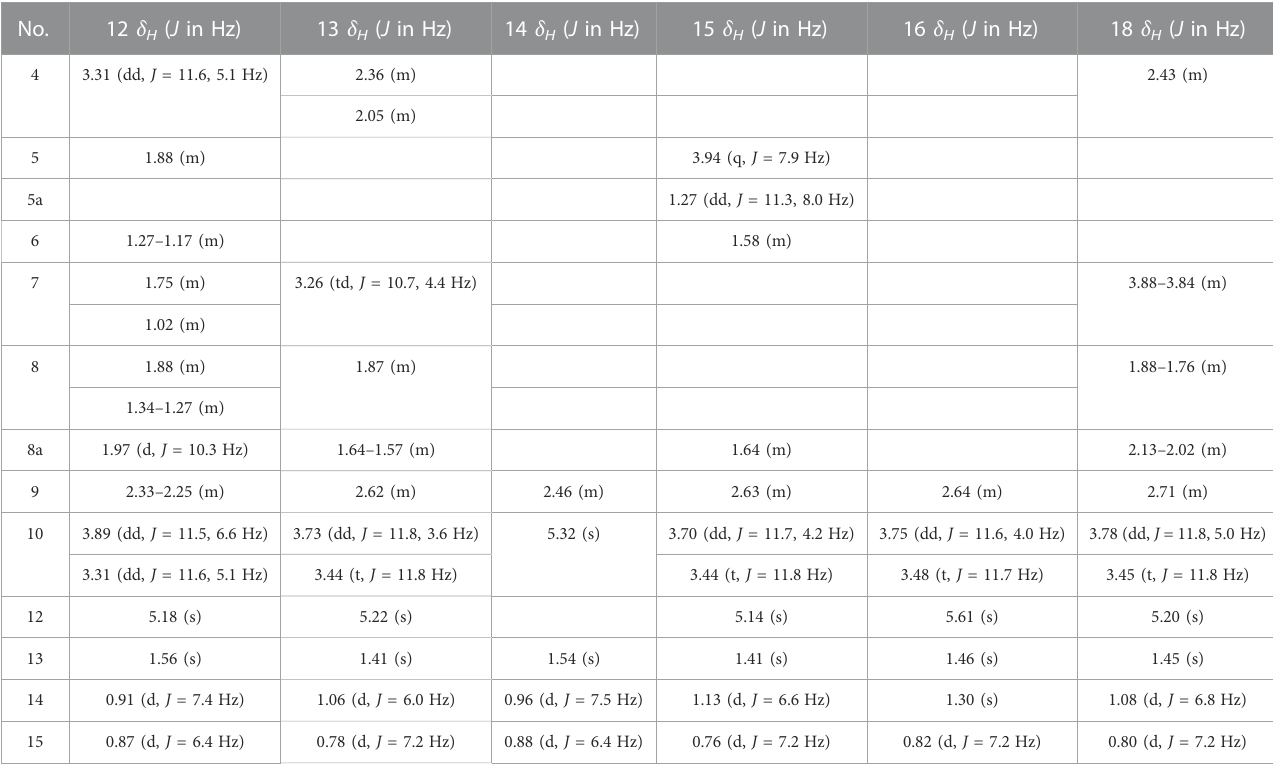
TABLE 3 1 H-NMR spectral data ( δ ) for compounds 12 – 16 and 18 .